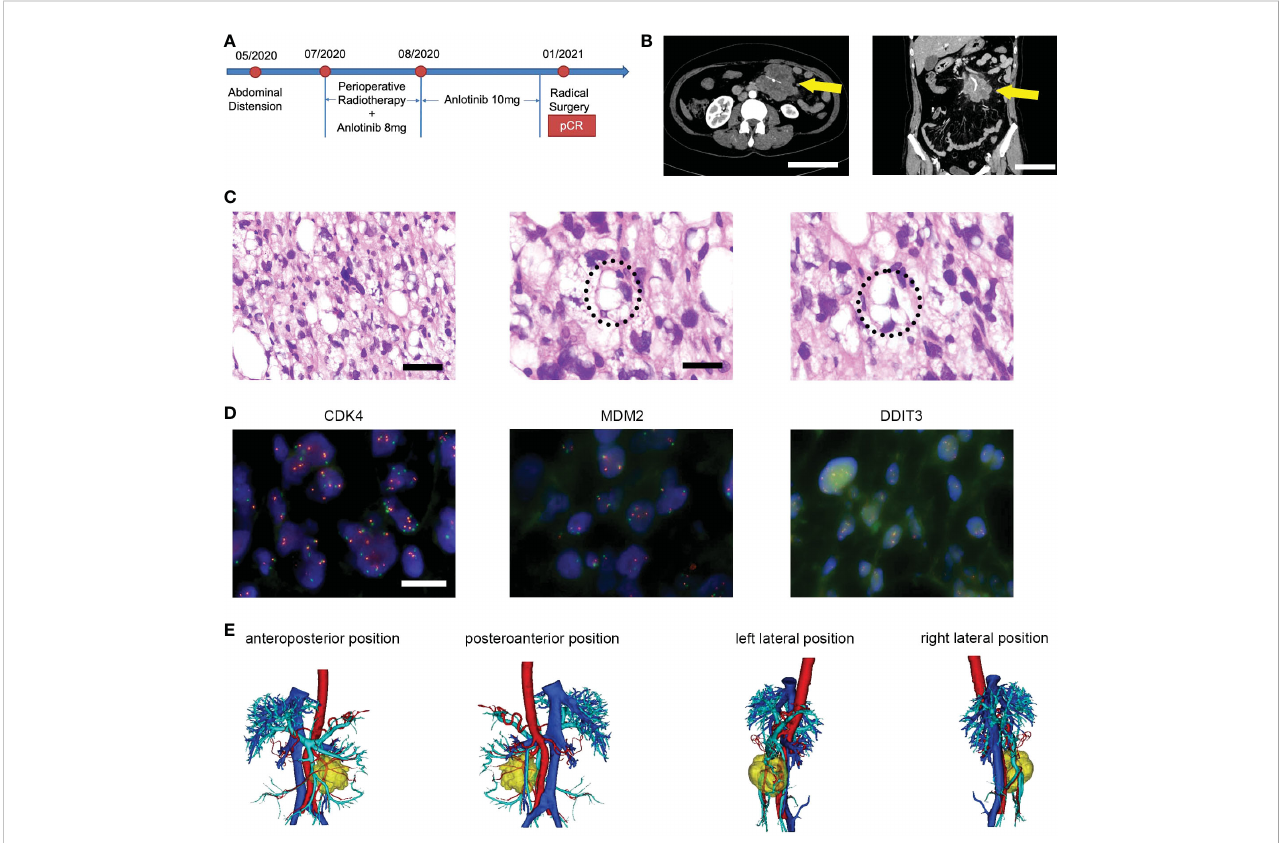
FIGURE 1 (A) Timeline of therapy in a patient with unresectable PLPS who received preoperative RT plus anlotinib and achieved pCR after the surgery. (B) The initial CT scan revealed a soft tissue mass in the left abdominal cavity with the superior mesenteric artery passing through, measuring 7.4 cm × 6.2 cm × 7.2 cm in diameter. Scale bar = 10 cm. (C) Micrographs of hematoxylin and eosin (HE) staining. Scale bar = 50 m m. The latter two images showed the lip blasts in a circle. Scale bar = 25 m m. (D) The FISH image showed negative results labeled by CDK4, MDM3, and DDIT3 probes, respectively. Scale bar = 10 m m. (E) 3D reconstruction imaging displayed the relationship between tumors and vessels. Yellow, tumor; red, artery; blue,